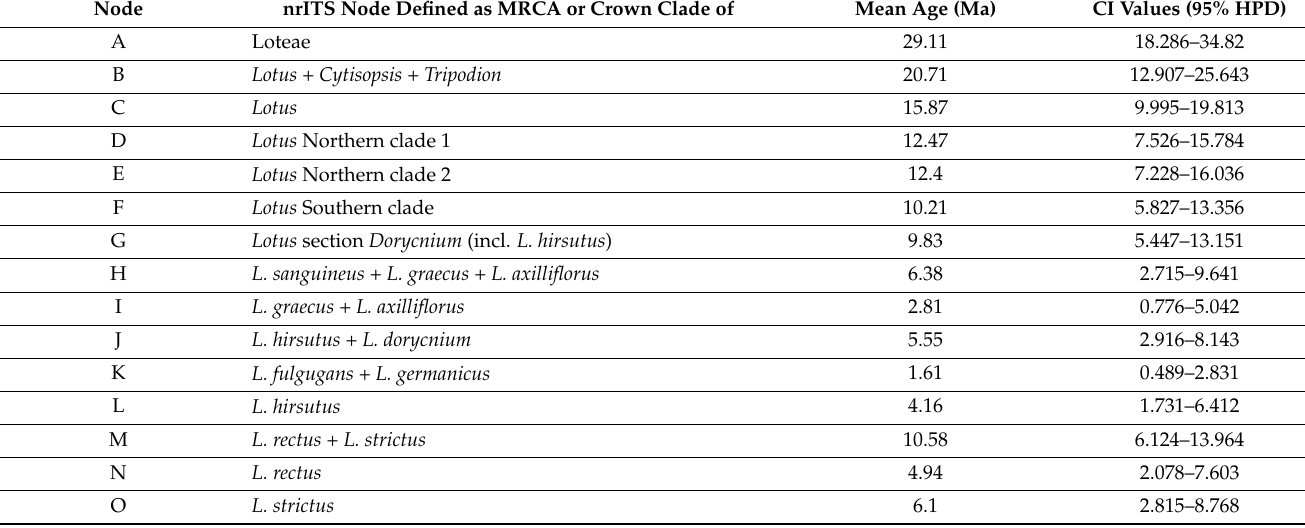
Figure 8. Chronogram summarizing results of the Bayesian dating analysis of nrITS dataset (74 accessions representing the genus Lotus , thirteen other genera of Loteae and Sesbania , Robinia , and Coursetia as outgroup). Mean age estimates in million years (Ma) are indicated for nodes, with node bars showing the associated 95% HPD credibility intervals. Age constraints were applied to nodes marked by green dots. Branch colors correspond to inferred mean substitution rates according to the scale bar. The major clades ( A – O ) are described in Table 2. Table 2. Estimated divergence times of the major clades within Loteae and Lotus, obtained with an uncorrelated lognormal clock model under a Birth-death speciation